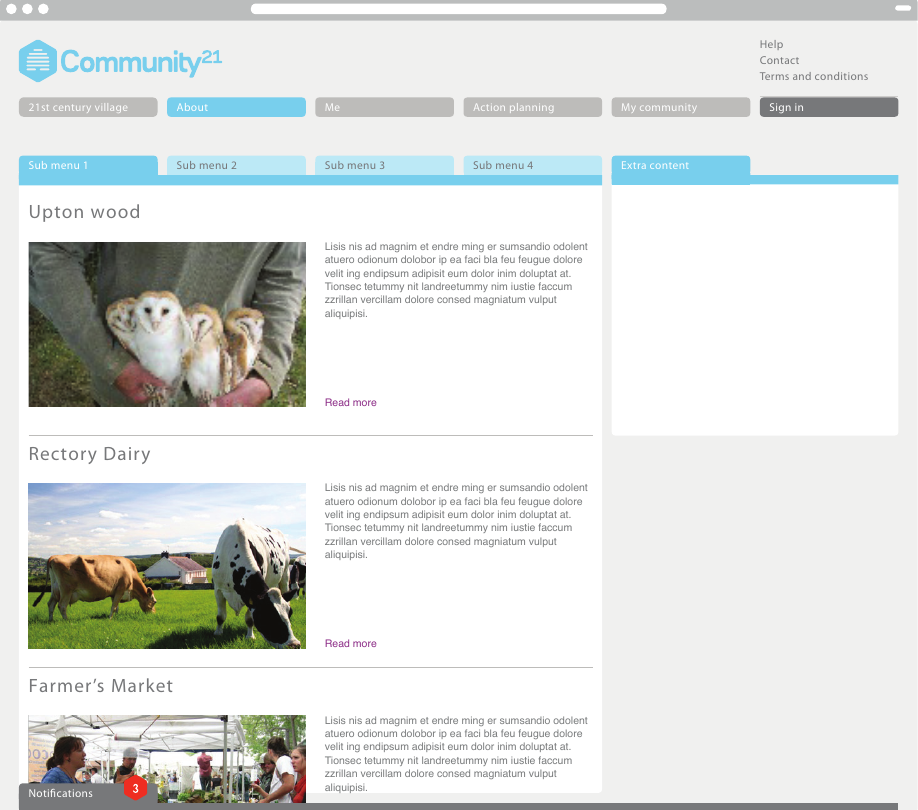
Figure 3: Image of